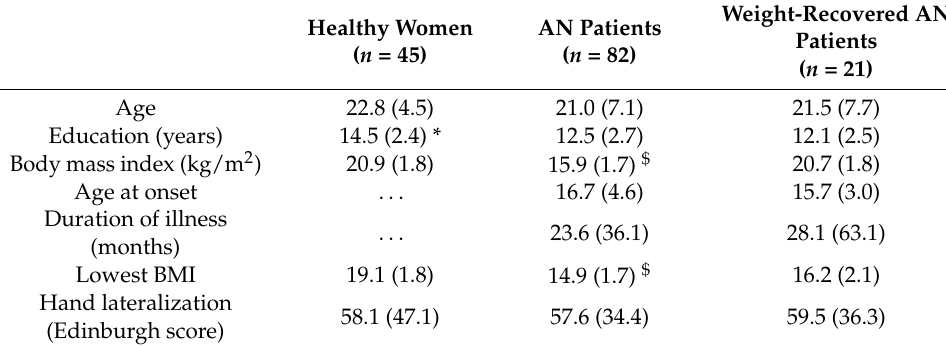
Table 3. Demographic and clinical characteristics of the